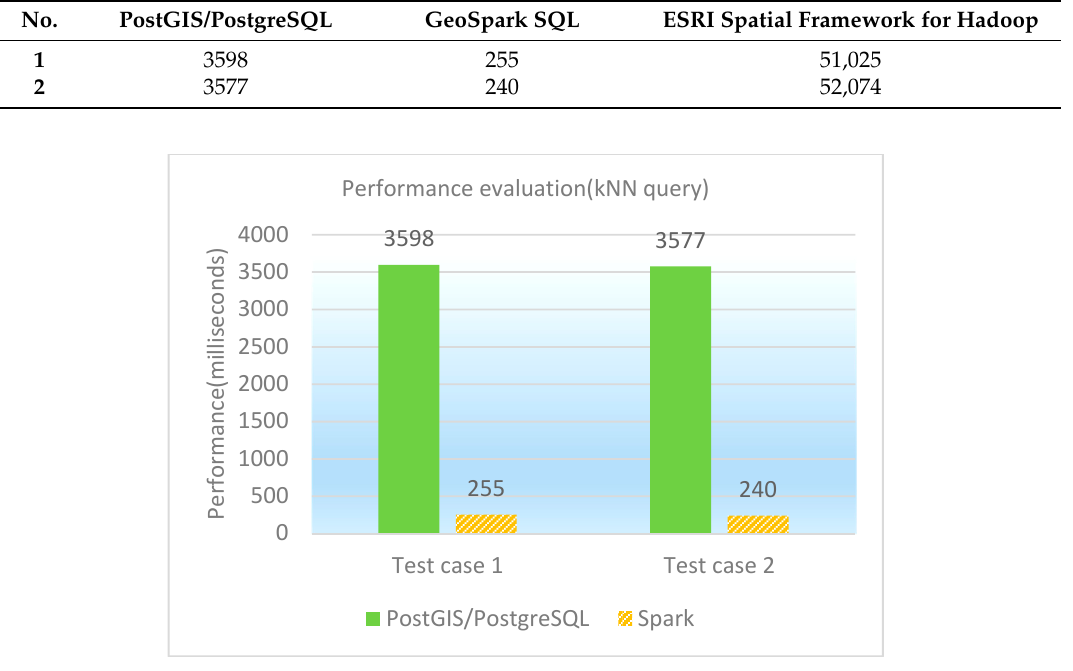
Figure 6. Performance comparison graph of kNN queries (in milliseconds).